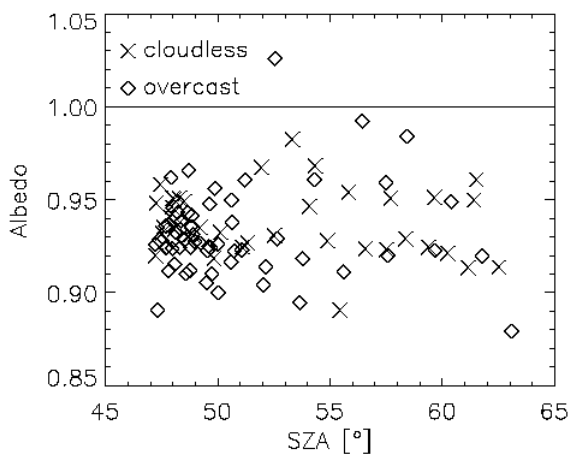
Fig. 6. All albedo values derived from measurements with the SL501 as a function of SZA.